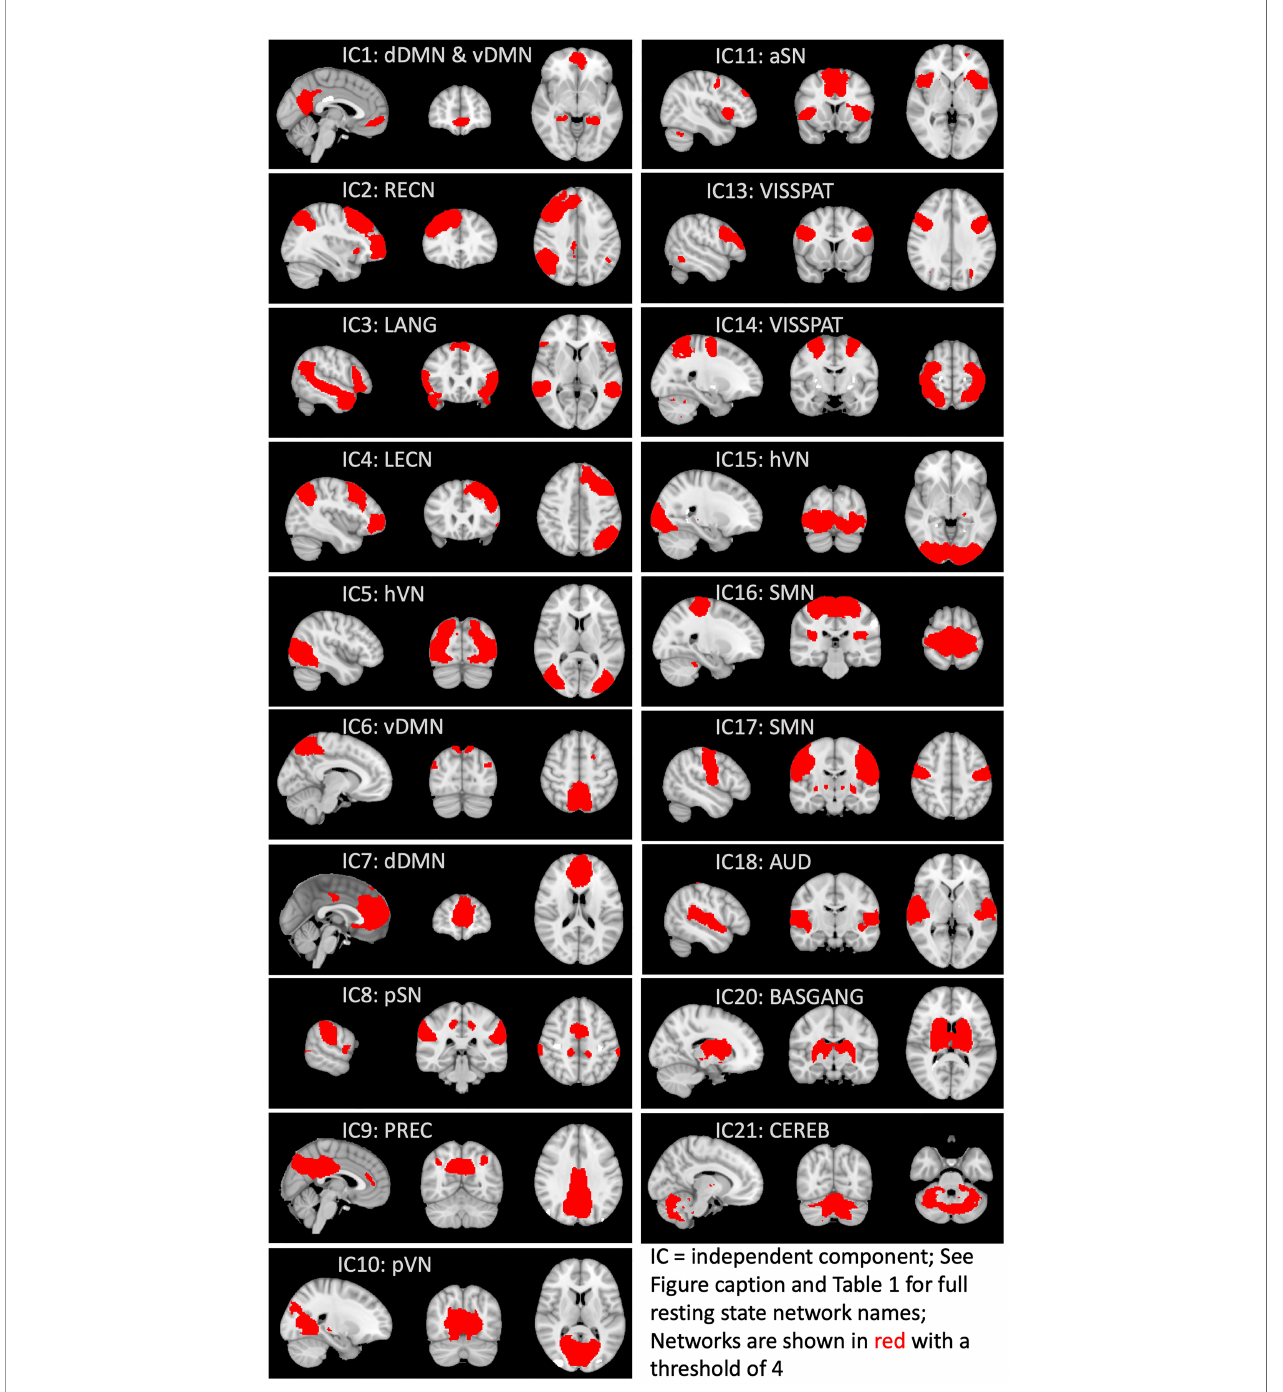
FIGURE 1 | Functional connectivity networks derived from group independent component analysis. Network names are from the Find Lab atlas (71). Independent components (ICs) 12, 19, and 22-25 were discarded because they were primarily localized in white matter, did not re fl ect activity restricted primarily to gray matter, or represented noise/artifacts. DMN, default mode network; vDMN, ventral DMN; dDMN, dorsal DMN; RECN, right executive control network; LANG, language network; LECN, left executive control network; hVN, high visual network; pSN, posterior salience network; PREC, precuneus network; pVN, primary visual network; aSN, anterior salience network; VISSPAT, visuospatial network; SMN, sensorimotor network; AUD, auditory network; BASGANG, basal ganglia network; CEREB,